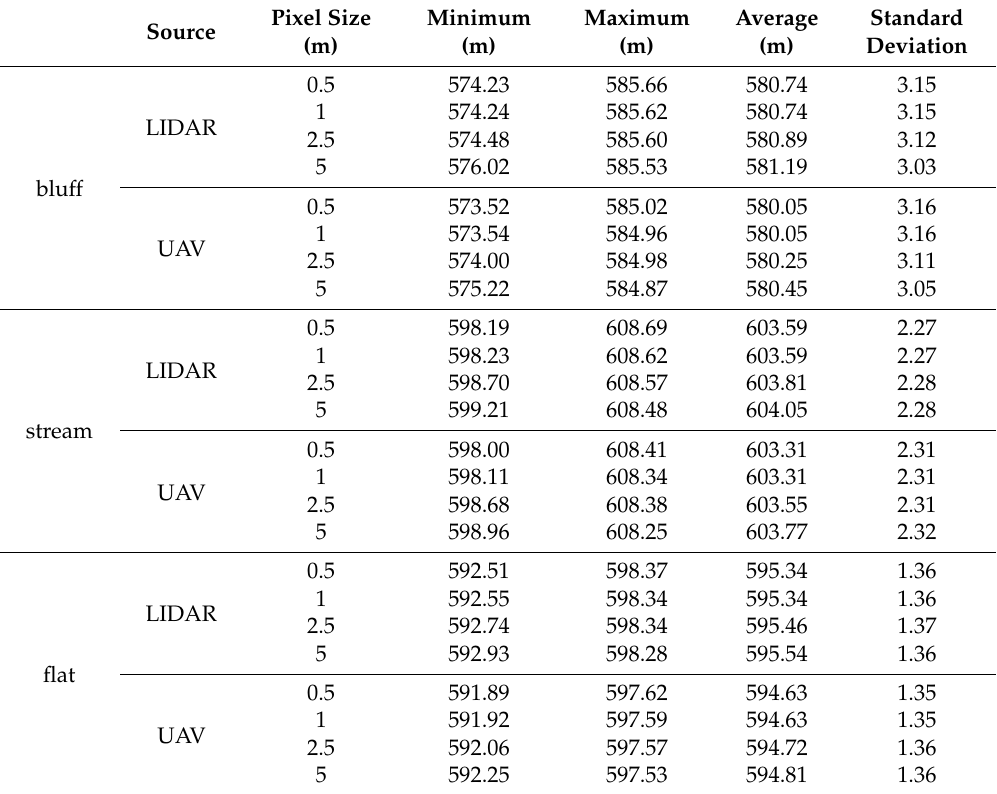
Table 5. Statistics of the digital elevation